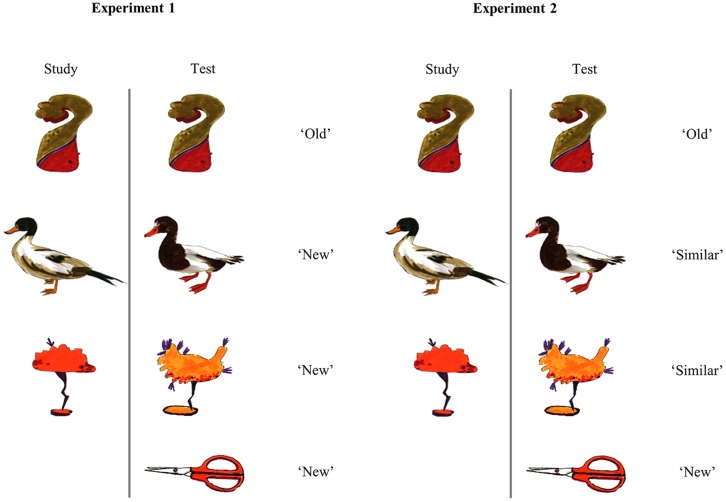
Examples of study and test stimuli employed in Experiment 1 (test response options “Old” and “New”) and Experiment 2 (test response options “Old,” “Similar” and “New,” and the correct response associated with each image at test. Stimuli taken from Koutstaal et al. (2003).